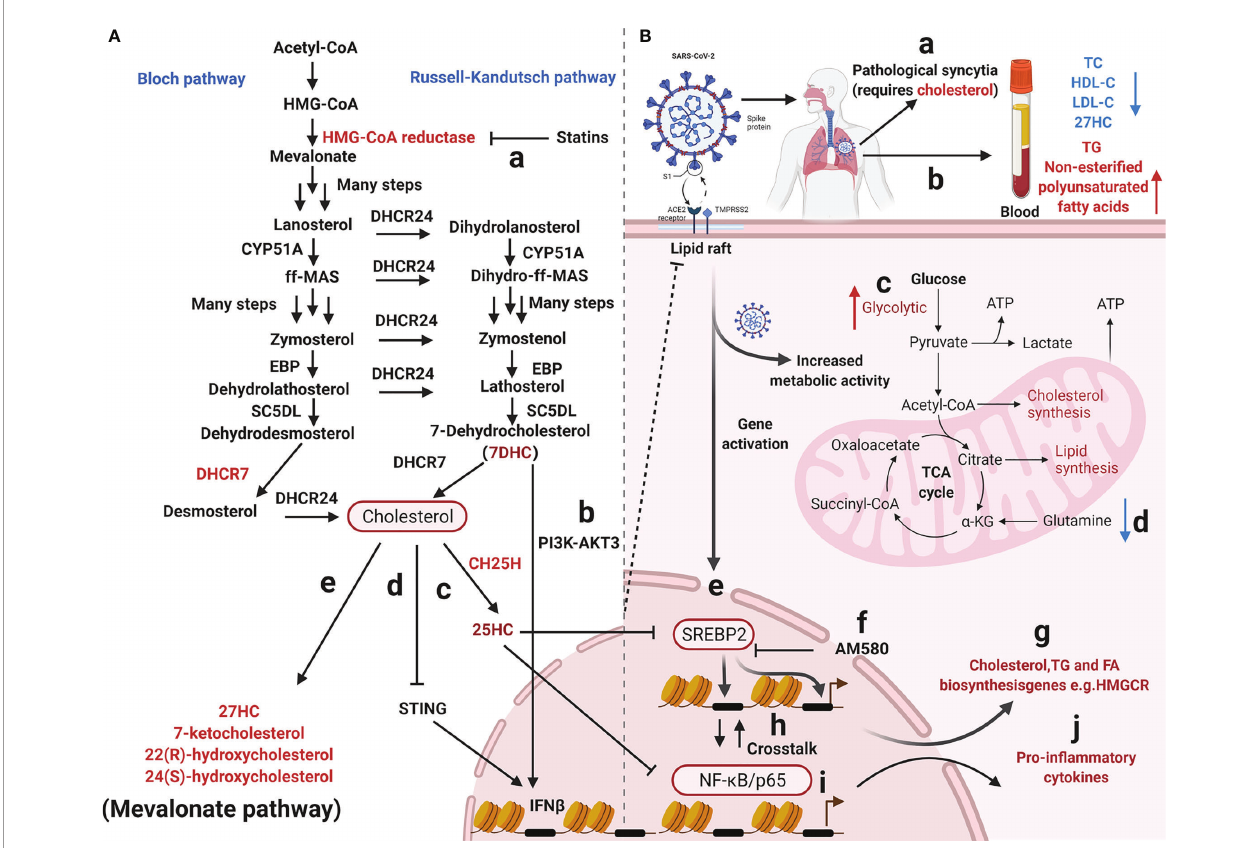
FIGURE 2 | Overview of mevalonate pathway and coronavirus infection. (A) Cholesterol metabolizing enzymes and metabolites act against viral infectivity. Red type represents cholesterol metabolizing enzymes or corresponding natural products which may be used as drug targets or directly to exert antiviral effects. (a) HMG-CoA reductase regulates cholesterol biosynthesis and is targeted by statins. (b, c, d) The sterol metabolic network participates in interferon (IFN) antiviral responses. (e, f) SARS-CoV-2 propagation in cultured cells is inhibited by various cholesterol molecules and semi-synthetic oxysterols. The detailed steps of the cholesterol synthesis pathway can be found in (180 – 182). (B) Cholesterol metabolism reprogramming and antiviral responses after viral infection. (a) Cholesterol promotes pathological syncytial formation during SARS-COV-2 infection. (b) Serum TC, TG, and non-esteri fi ed polyunsaturated fatty acid levels are remodeled in COVID-19 patients. (c, d) SARS-CoV-2 infection increases glucose entry into the TCA cycle via increased pyruvate carboxylase expression and reduced oxidative glutamine metabolism, while maintaining reductive carboxylation. (f) SREBP-dependent lipidomic reprogramming is a broad-spectrum antiviral target, AM580 strongly inhibits coronavirus replication by interacting with SREBP-2. (e, h, g, i, j) COVID-19-activated SREBP-2 disturbs cholesterol biosynthesis, leading to a cytokine storm. Importantly, SREBP-2 activity is regulated by crosstalk between cholesterol consumption and NF- k B expression via several in fl ammatory response processes induced by SARS-CoV-2 infection. Red arrows represent upregulation and blue arrows represent downregulation. Acetyl-CoA, Acetyl-Coenzyme A; HMG-CoA, 3-hydroxy-3-methylglutaryl-coenzyme A; EBP, D (7)-isomerase; DHCR24, 3- b -hydroxysteroid- D -24-reductase; SC5DL, Sterol C5-desaturase; DHCR7, 7-dehydrocholesterol reductase; CH25H, cholesterol-25- hydroxylase; 25HC, 25-hydroxycholesterol; 27HC, 27-hydroxycholesterol; IFN b , Interferon- b ; TC, Total cholesterol; HDL-C, High-density lipoprotein cholesterol; LDL-C, low-density lipoprotein cholesterol; TG, Triglyceride; ATP, Adenosine triphosphate; SREBP-2, Sterol regulatory element-binding protein 2; AM580, a selective RAR a agonist; HMGCR, 3-Hydroxy-3-Methylglutaryl Coenzyme A Reductase; NF- k B, Nuclear transcription factor- k